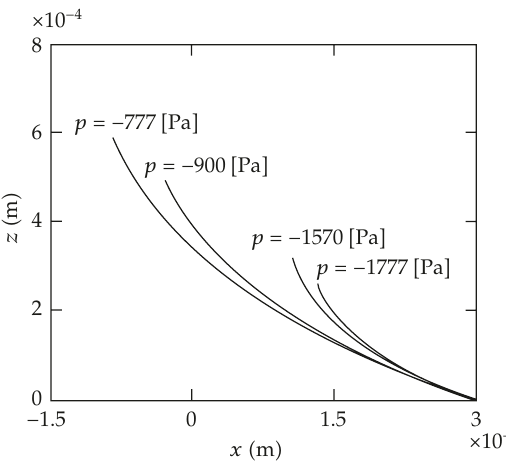
Figure 4: z versus x for p (cid:8) − 1777; − 1570; − 900; − 777 (cid:6) Pa (cid:7) .